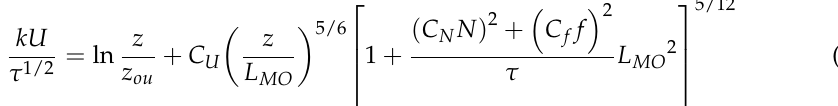
Figure 5. Hourly averaged values of ℎ from 00:00 on 3 August 2020 to 00:00 on 7 August 2020.